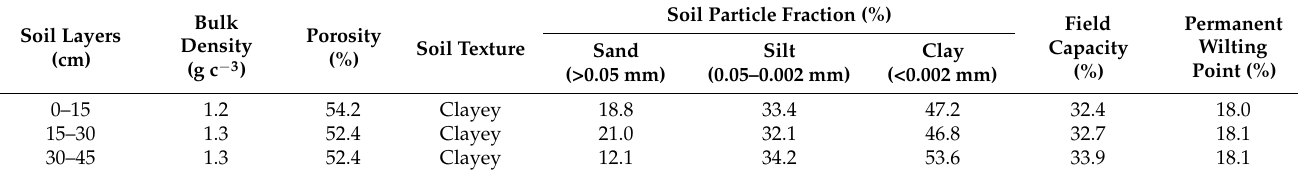
Table 10. Selected soil physico-chemical properties of the experimental